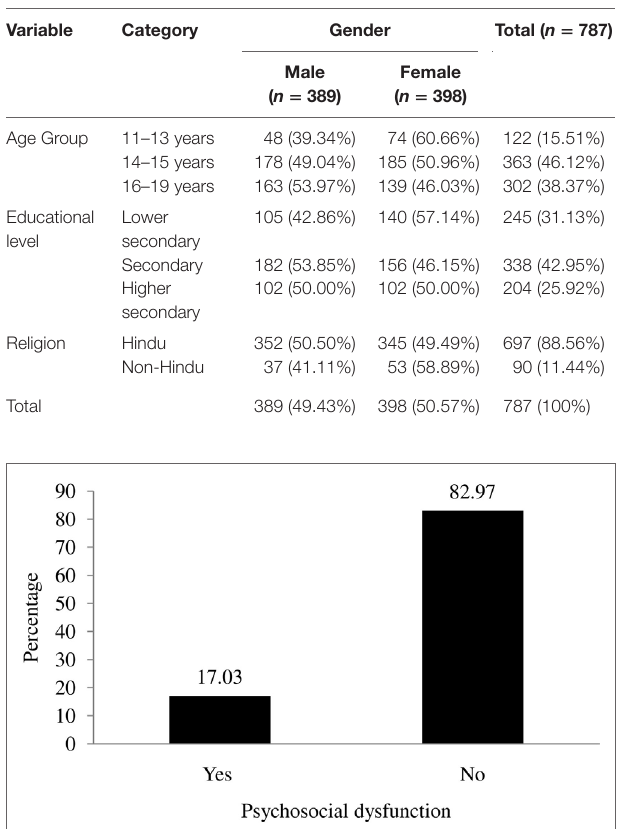
TaBle 1 | Distribution of respondents by socio-demographic